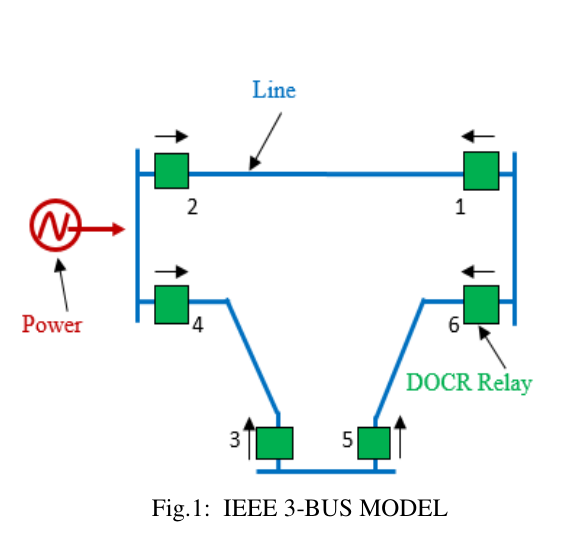
Fig.1: IEEE 3-BUS MODEL